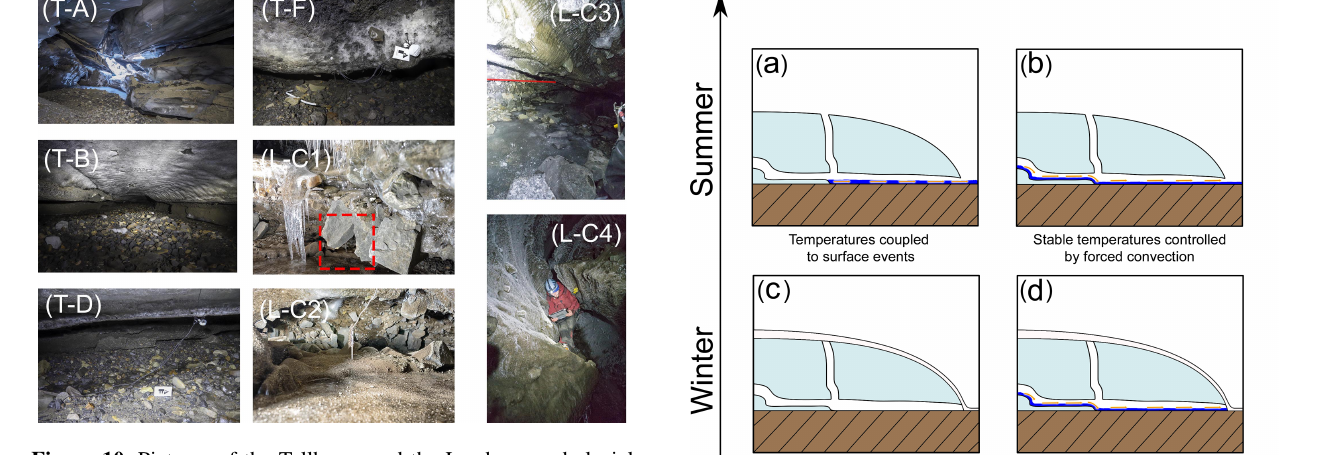
Figure 10. Pictures of the Tellbreen and the Larsbreen subglacial drainage system after the summer melt seasons. (T-A) Area A from Fig. 3 at the Tellbreen subglacial drainage system with collapsed roof area (date: 6 October 2019). (T-B) Area B from Fig. 3 at the Tellbreen subglacial drainage system with stranded icebergs on the higher banks, indicating a flood event (date: 6 October 2019). (T-D) Area D from Fig. 3 with logger Subglacial 1 and sediment sensors, which have been moved (date: 6 October 2019). (T-F) Area F from Fig. 3 with logger Subglacial 2, where both sediment loggers were eroded completely out of the sediment. (date 6 October 2019). (L- C1) Area C from Fig. 2 at the Larsbreen subglacial drainage system; note the sensor being eroded out of the ground in the lower part of the picture (red frame) (date: 30 November 2016). (L-C2) Close-up of the eroded 1.05m depth sediment sensor at the Larsbreen sub- glacial drainage system (date: 30 November 2016). (L-C3) Look- ing downstream at location C from Fig. 2 inside the Larsbreen sub- glacial drainage system. Note the channel floor from the previous winter marked in red (date: 30 November 2016). (L-C4) Download- ing data from the loggers at location C from Fig. 2, where the chan- nel has further incised during the melt season (date: 30 November 2016).